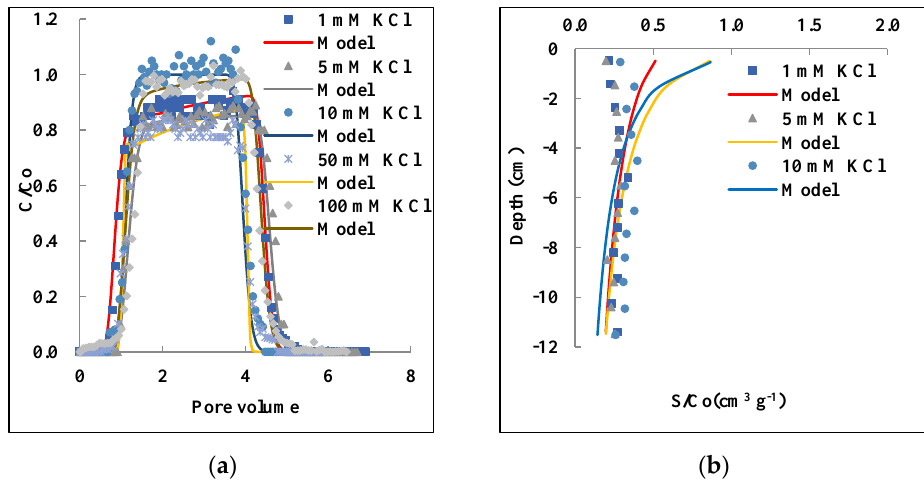
Figure 3. Effect of ionic strength 1, 5, 10, 50, and 100 mM on the transport and retention of PAM@MNP in saturated QS: Observed and modeled BTCs ( a ) and RPs ( b ). Initial concentration: 10 mg L −1 ; grain size: 607 μm, Darcy velocity: 0.29– 3.0 cm min −1 .